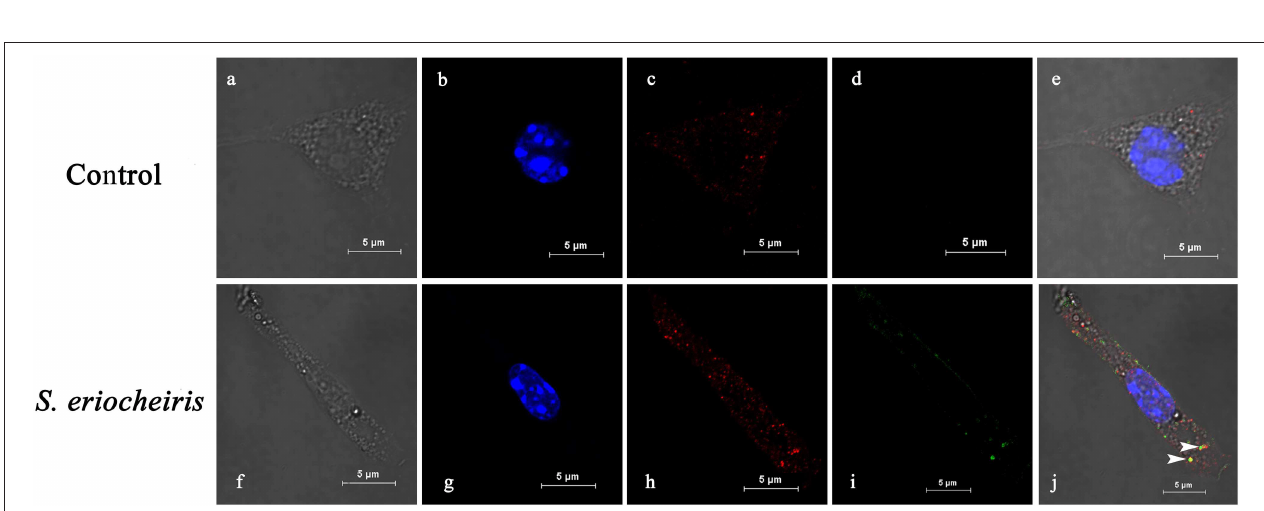
FIGURE 2 | Spiroplasma eriocheiris bind to the MrLGBP protein of M. rosenbergii hemocyte. The co-localization of MrLGBP and S. eriocheiris in prawn hemocytes was analyzed by confocal microscopy. Hemocytes were immobilized after S. eriocheiris injection for 16h. Spiroplasma were stained by Alexa Flour 488 goat anti-rabbit IgGs (green). MrLGBP were stained used the mouse anti-MrLGBP as primary antibody and donkey anti-mouse IgG Alexa-555 as the second antibody (red). Nuclei were stained with DAPI (blue). Hemocytes were visualized by bright field (a,f) , blue fluorescence only (b,g) , red fluorescence only (c,h) , green fluorescence only (d,i) , and by bright field merge with all fluorescent molecules (e,j) in both the non-infected and S. eriocheiris infected group. The white arrows indicate co-localization of MrLGBP and S. eriocheiris . Bars = 5 µ m.